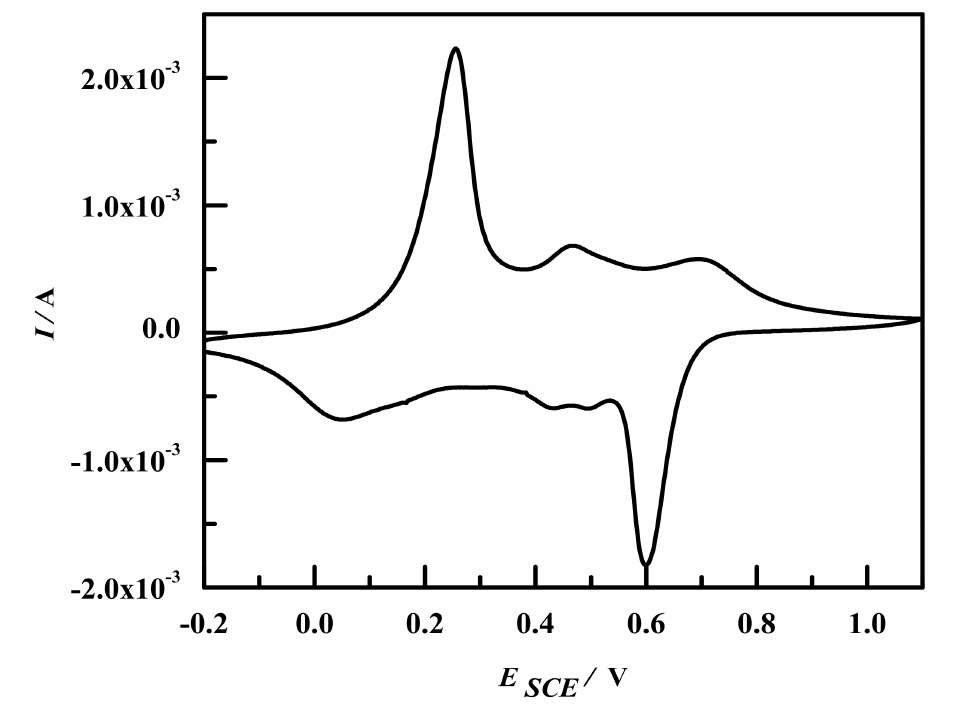
Figure 2. Cyclic voltammogram of PACHA coated gold electrode in 0.5 M sulphuric acid solution at 50 mV/s.